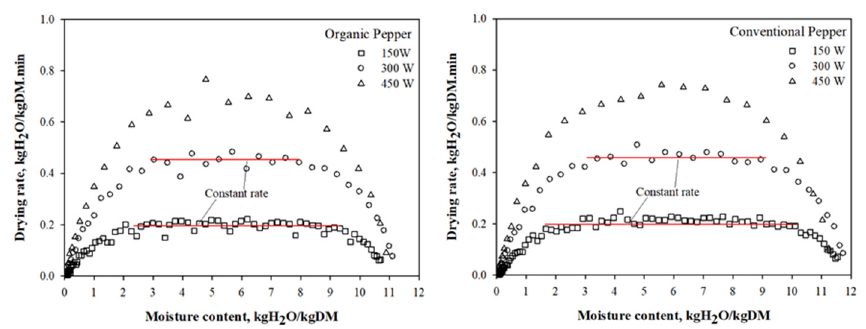
Figure 3. Change of drying rate as a function of moisture content for intermittent microwave drying of organic and conventional sweet red pepper shreds.